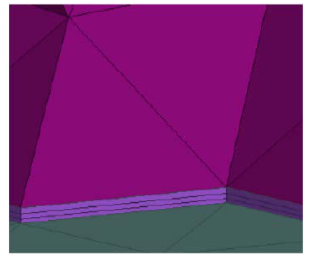
Figure 11. Boundary layer grids.